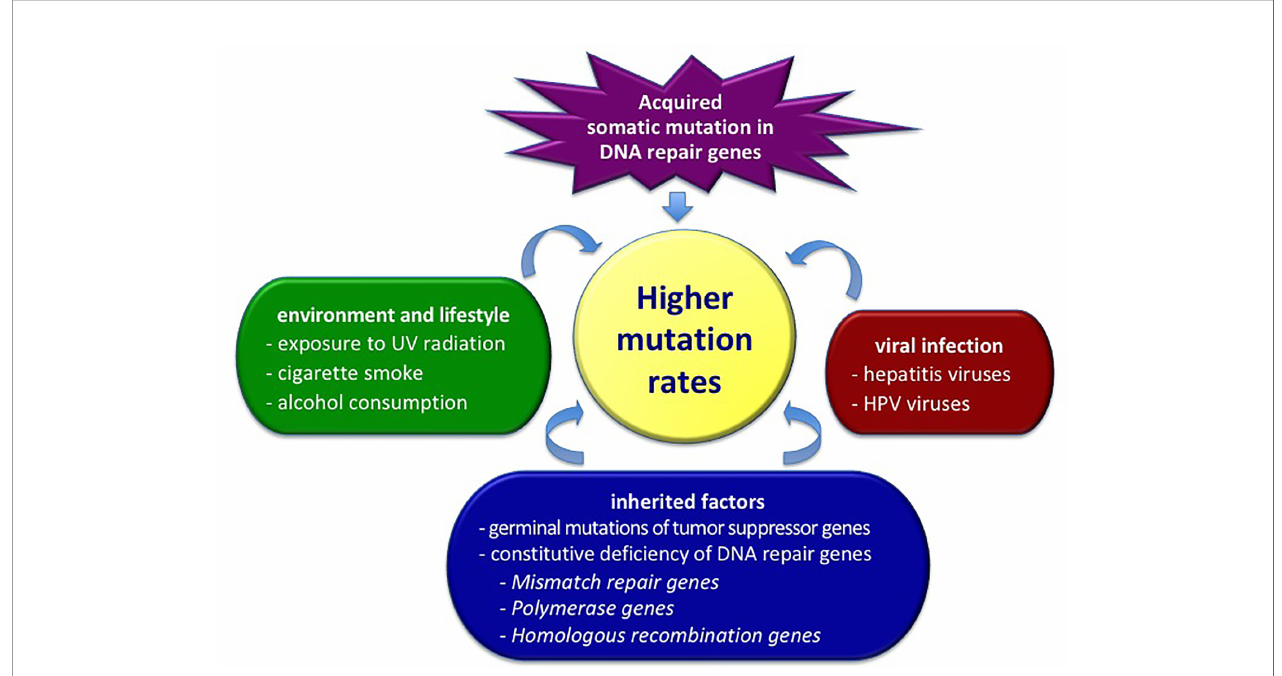
FIGURE 1 | Factors determining the total level of mutations in cancer cells. HPV, human papilloma virus; UV, ultraviolet